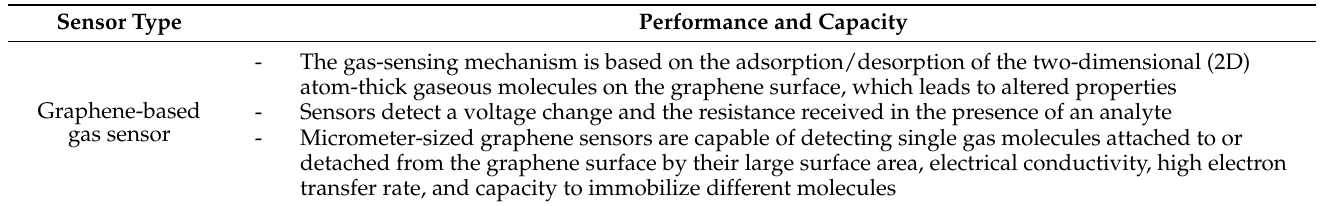
Table 1. Performance comparison between the graphene-based gas sensor and other types of gas sensors. Sensor